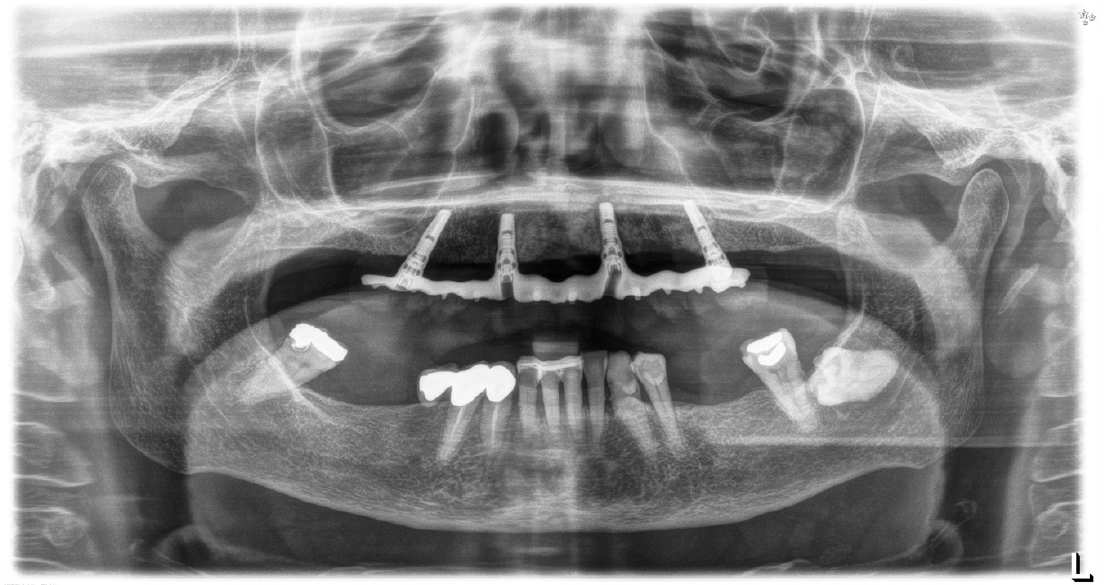
Figure 21. Final rx opt of the rehabilitation.